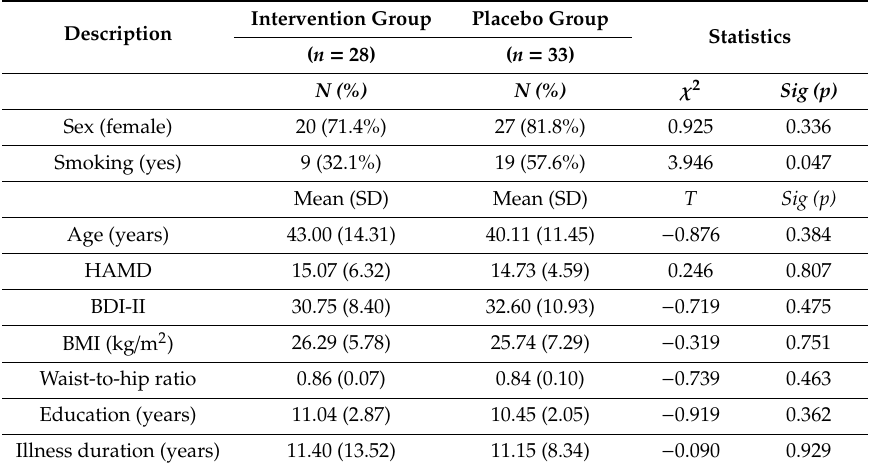
Table 1. Description of the study cohort at baseline (t0).